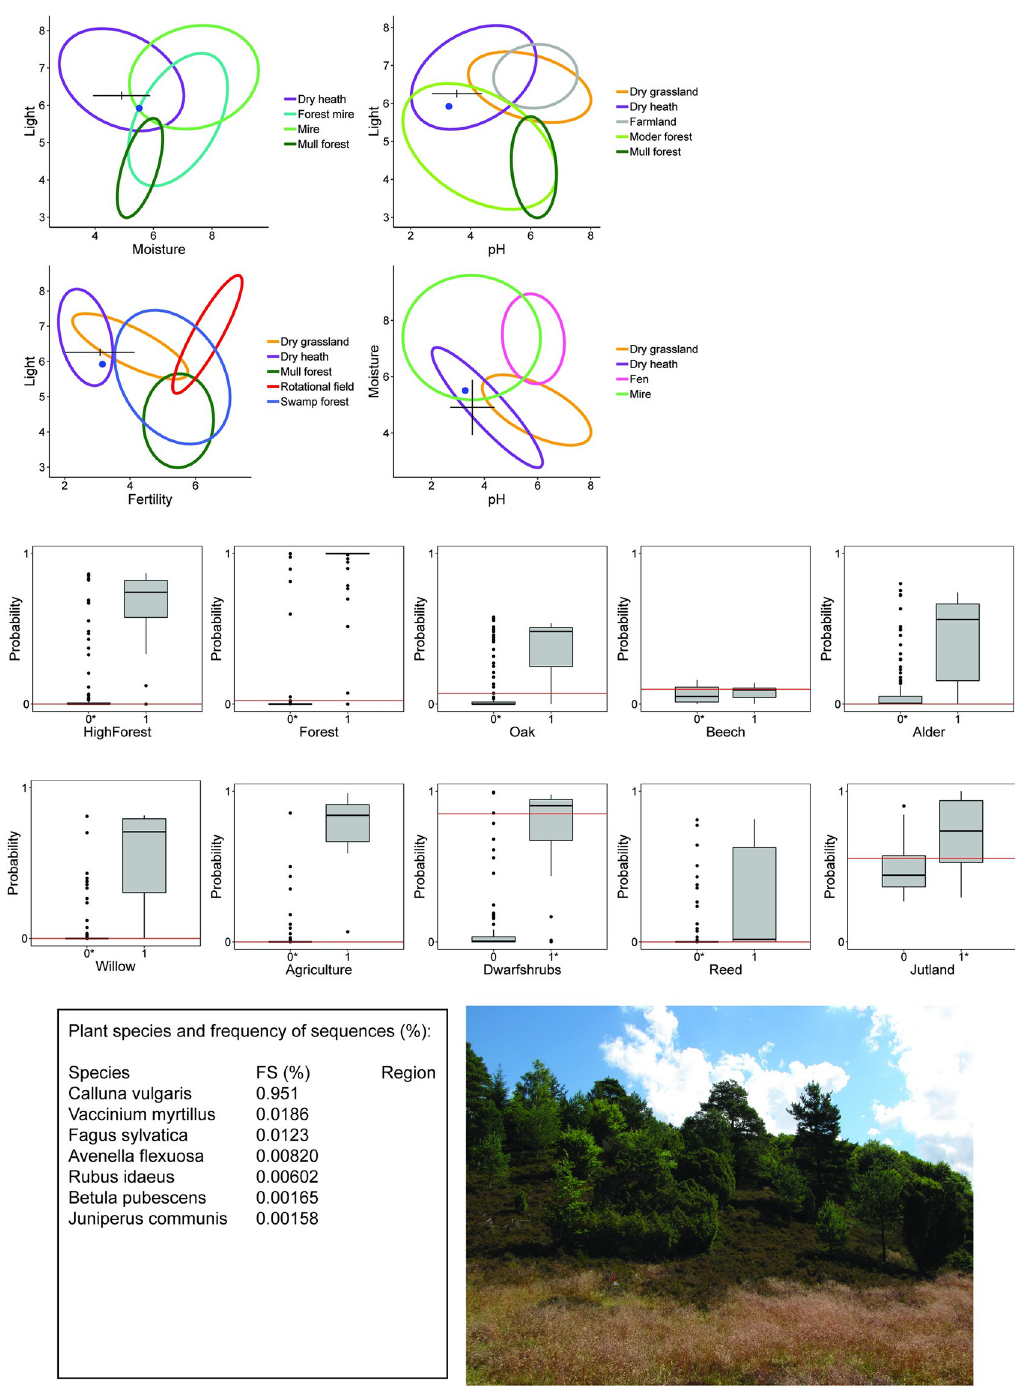
Fig 3. Mock crime scene 2 and the provenance derived from soil eDNA. Predicted location in environmental space (Ellenberg Indicator Values) based on the best linear models and GAM for light (top left). The cross marks the predicted EIV value and the length of the arms show the 95% confidence intervals. Blue dots show the actual EIVs at the sample site. The predicted probability of binary habitat types based on Quadratic Discriminant Analysis are shown as red lines on a box plot of the distribution of predicted values for each characteristic (middle part). A priori classification membership is indicated by asterisk of the 0/1 variable. The probabilities for heathland, coniferous and Atlantic are not shown. A list of plant species sequences, their frequency of sequences (FS) in the sample, and if applicable, the geographic region of their distribution in Denmark is listed bottom left. For evaluation, we provide a picture of the sample location (bottom right).